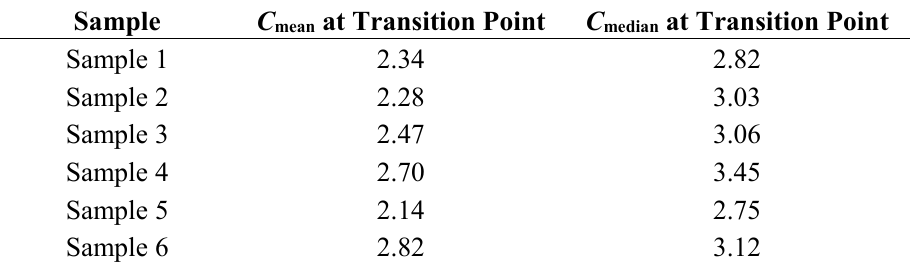
Table 1. The statistical results of AE signal.